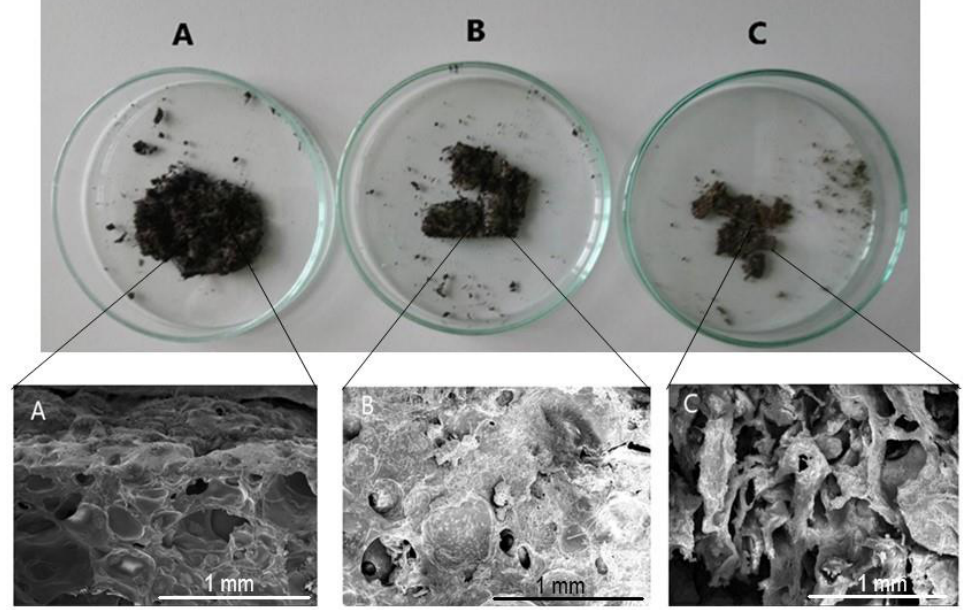
Figure 12. Visual degradation and SEM micrographs of hydrogel H15CA after ( A ) 5 days, ( B ) 10 days and ( C ) 20 days in soil, respectively.